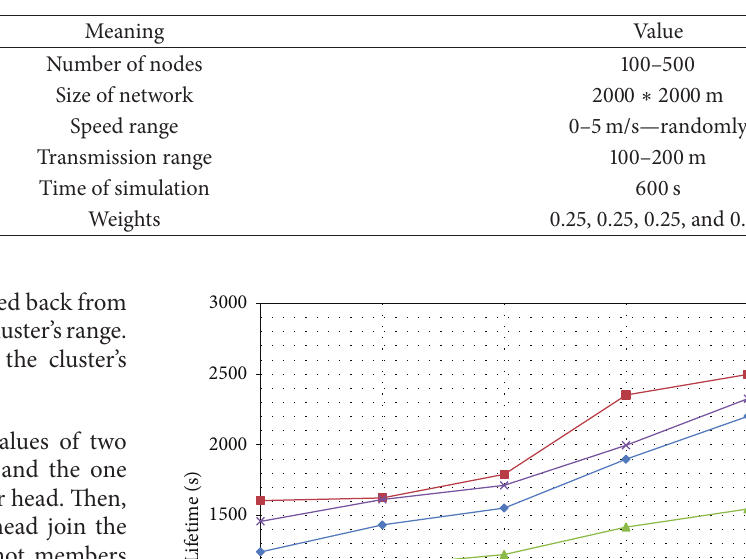
Table 2: Simulation parameters in NS2 simulator.